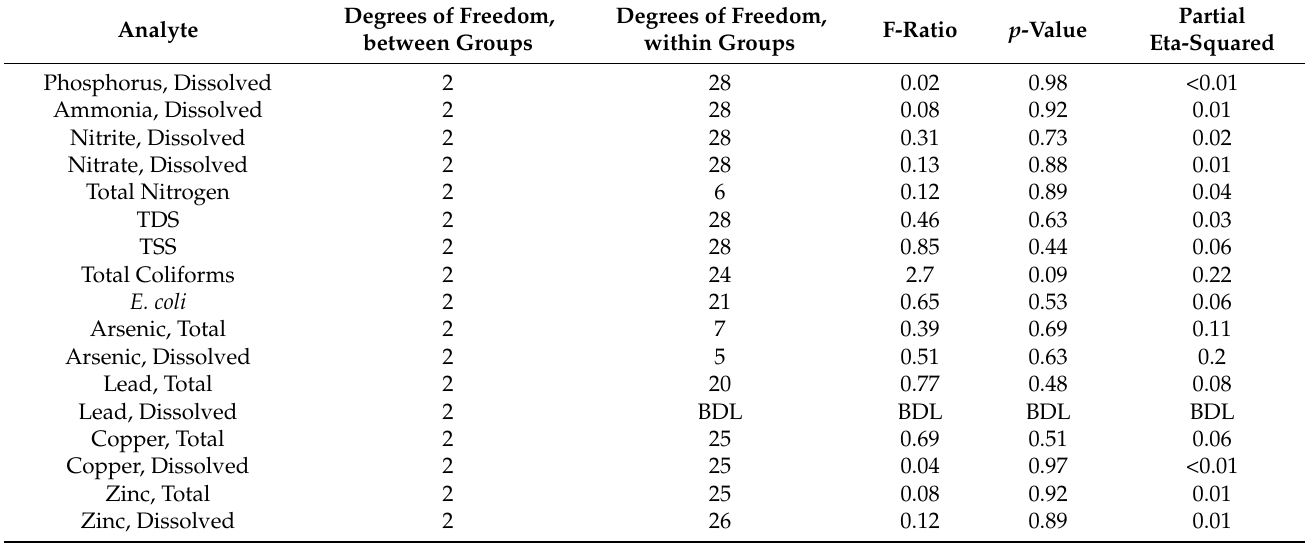
Table A5. ANCOVA results with total rainfall depth as the confounding variable. Degrees of Freedom, Analyte between